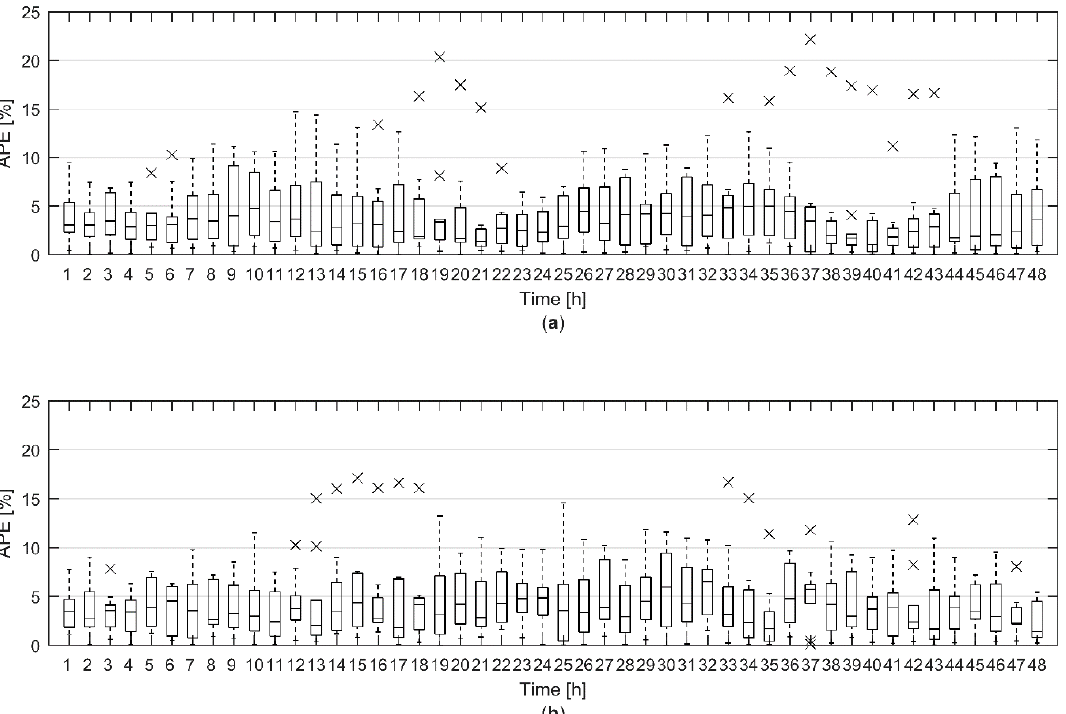
Figure 4. A box plot of the hourly absolute percentage error (APE) for the total heat demand forecast during the 48-h prediction horizon with ten validation data sets for ( a ) model A and ( b ) model B. For each box, the edges are the 25th and 75th percentiles, the central line marks the median, the dashed lines extend to the most extreme data points not considered outliers and the crosses mark the outliers.